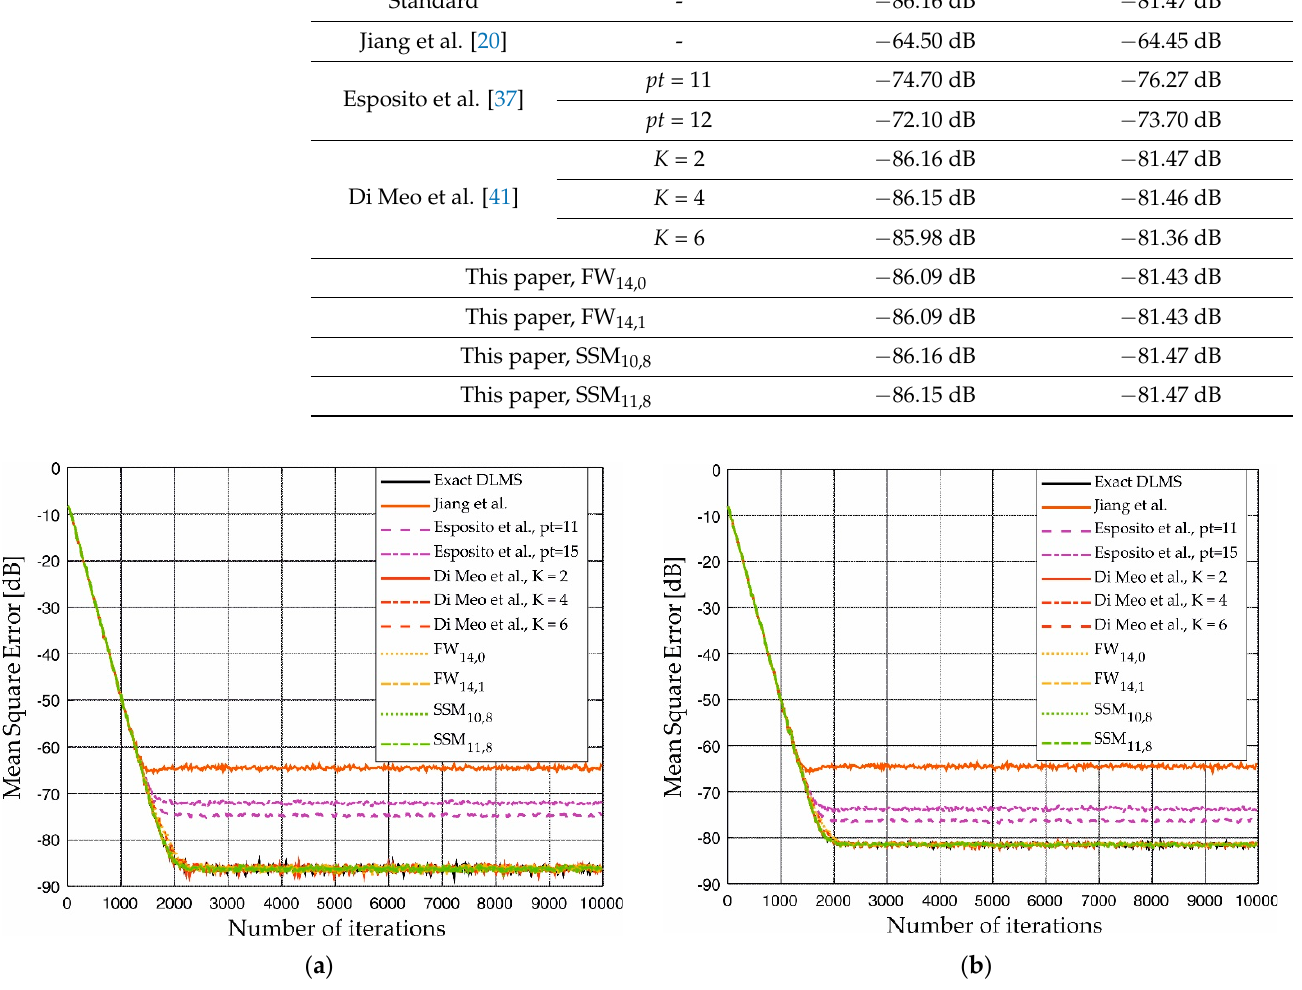
Figure 12. Learning curves in the case of ( a ) FIR identification and ( b ) IIR identification with approximation in the feedback. In the figure, we report also the learning curves of the implementations Jiang et al. [20], Esposito et al. [37], and Di Meo et al. [41].